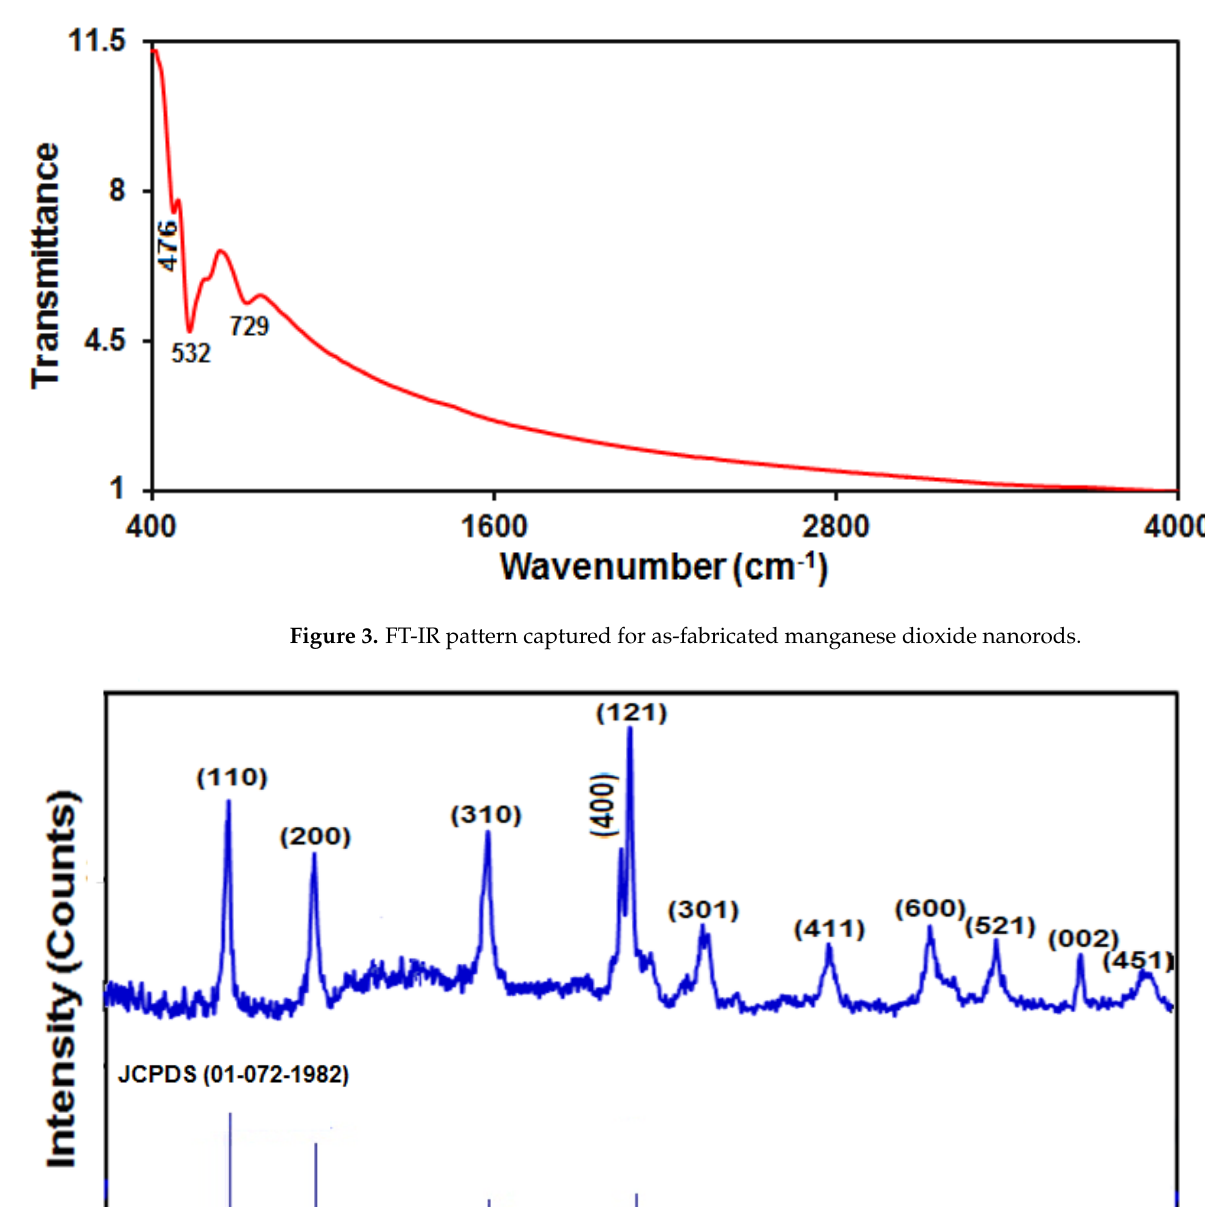
Figure 4. XRD spectrum captured for as-fabricated manganese dioxide nanorods.